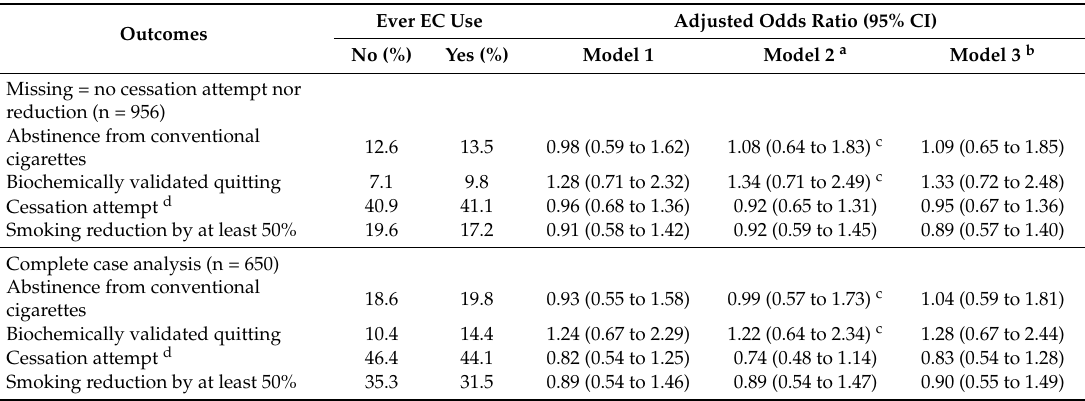
Table 3. Association of abstinence outcomes at the 6-month follow-up with ever EC use at 1-week